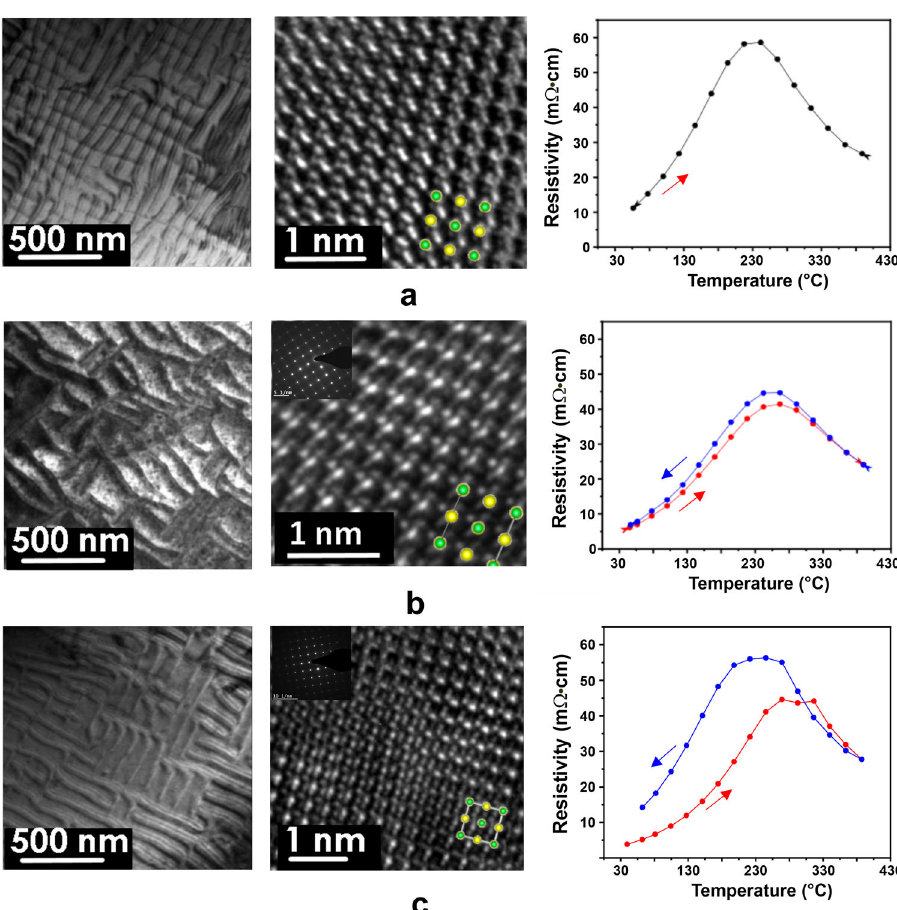
Fig. 4 Real structure and electronic transport behavior of the PbTe single crystal above room temperature. ( a ) pristine material; ( b ) after 128 h annealing at 400 °C; ( c ) after 128 h annealing at 600 °C. Stripes ’ network is shown in the left column, atomic structure – in the middle column (insets show FFT of the region), and electric resistivity – in the right